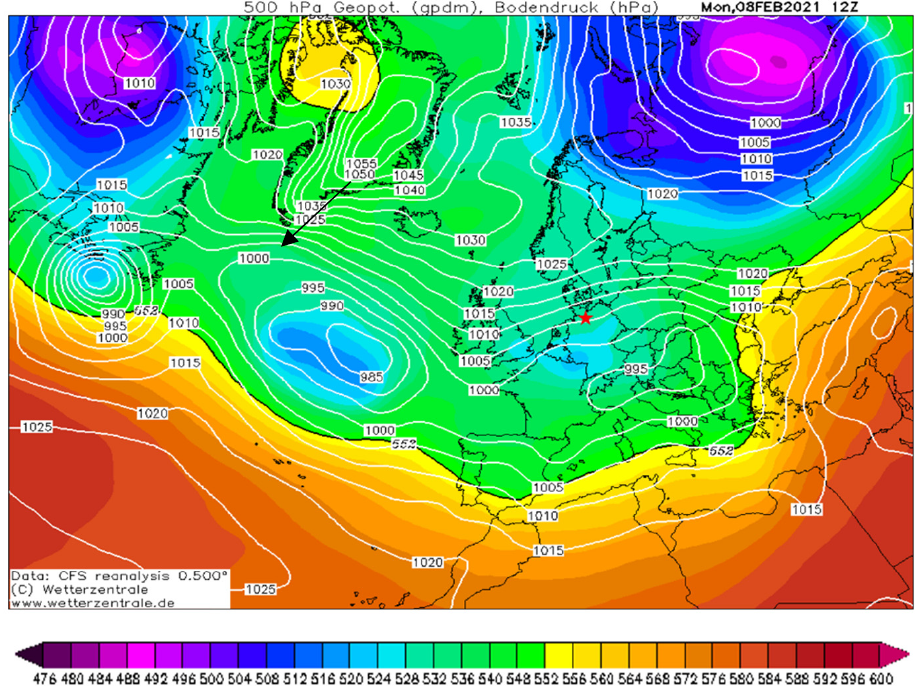
Figure 10. Map of the 500 hPa-geopotential height (in gpdm) and surface pressure (in hPa) for Day 1 (8 February 2021) when an easterly flow of clean polar air led to low PN concentrations in the area of interest. A relatively weak low-pressure system centered over Southeastern Europe and a strong high pressure over Greenland dominated the flow in Northern Europe. (Source: German Weather Central, www.wetterzentrale.de, CFS reanalysis; https://www.wetterzentrale.de/reanalysis.php?jaar=2021 &maand=2&dag=8&uur=1200&var=1&map=1&model=cfsr, accessed on 26 November 2021). The red star denotes the area of